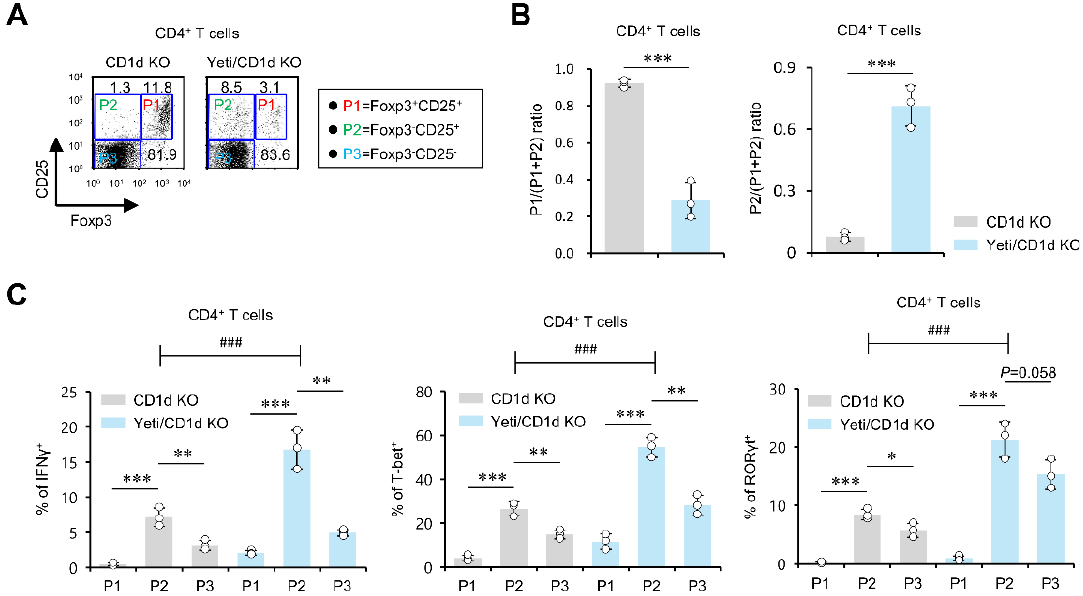
Figure 2. The MLN Foxp3 − CD25 + CD4 + T cells from DSS-treated Yeti/CD1d KO mice exhibit a pathogenic effector phenotype. ( A – C ) MLNs were obtained from CD1d KO and Yeti/CD1d KO mice on day ten after 1.5% DSS treatment. ( A ) The percentages of Foxp3 + CD25 + (P1), Foxp3 − CD25 + (P2), and Foxp3 − CD25 − (P3) populations among MLN CD4 + T cells were evaluated by flow cytometry. ( B ) The ratio of the P1 or P2 to the CD25 + CD4 + (P1 + P2) population was evaluated by flow cytometry. ( C ) I ntracellular expression of IFNγ, T - bet, and RORγt on P1, P2, and P3 populations of MLN CD4 + T cells from CD1d KO and Yeti/CD1d KO mice was evaluated by flow cytometry. The mean values ± SD ( n = 3; per group in the experime nt; Student’s t -test; * p < 0.05, ** p < 0.01, *** p < 0.001) are shown. Two-way ANOVA (Yeti × iNKT) showed an interaction between these two factors ( ### p < 0.001). One representative experiment from two experiments is shown.